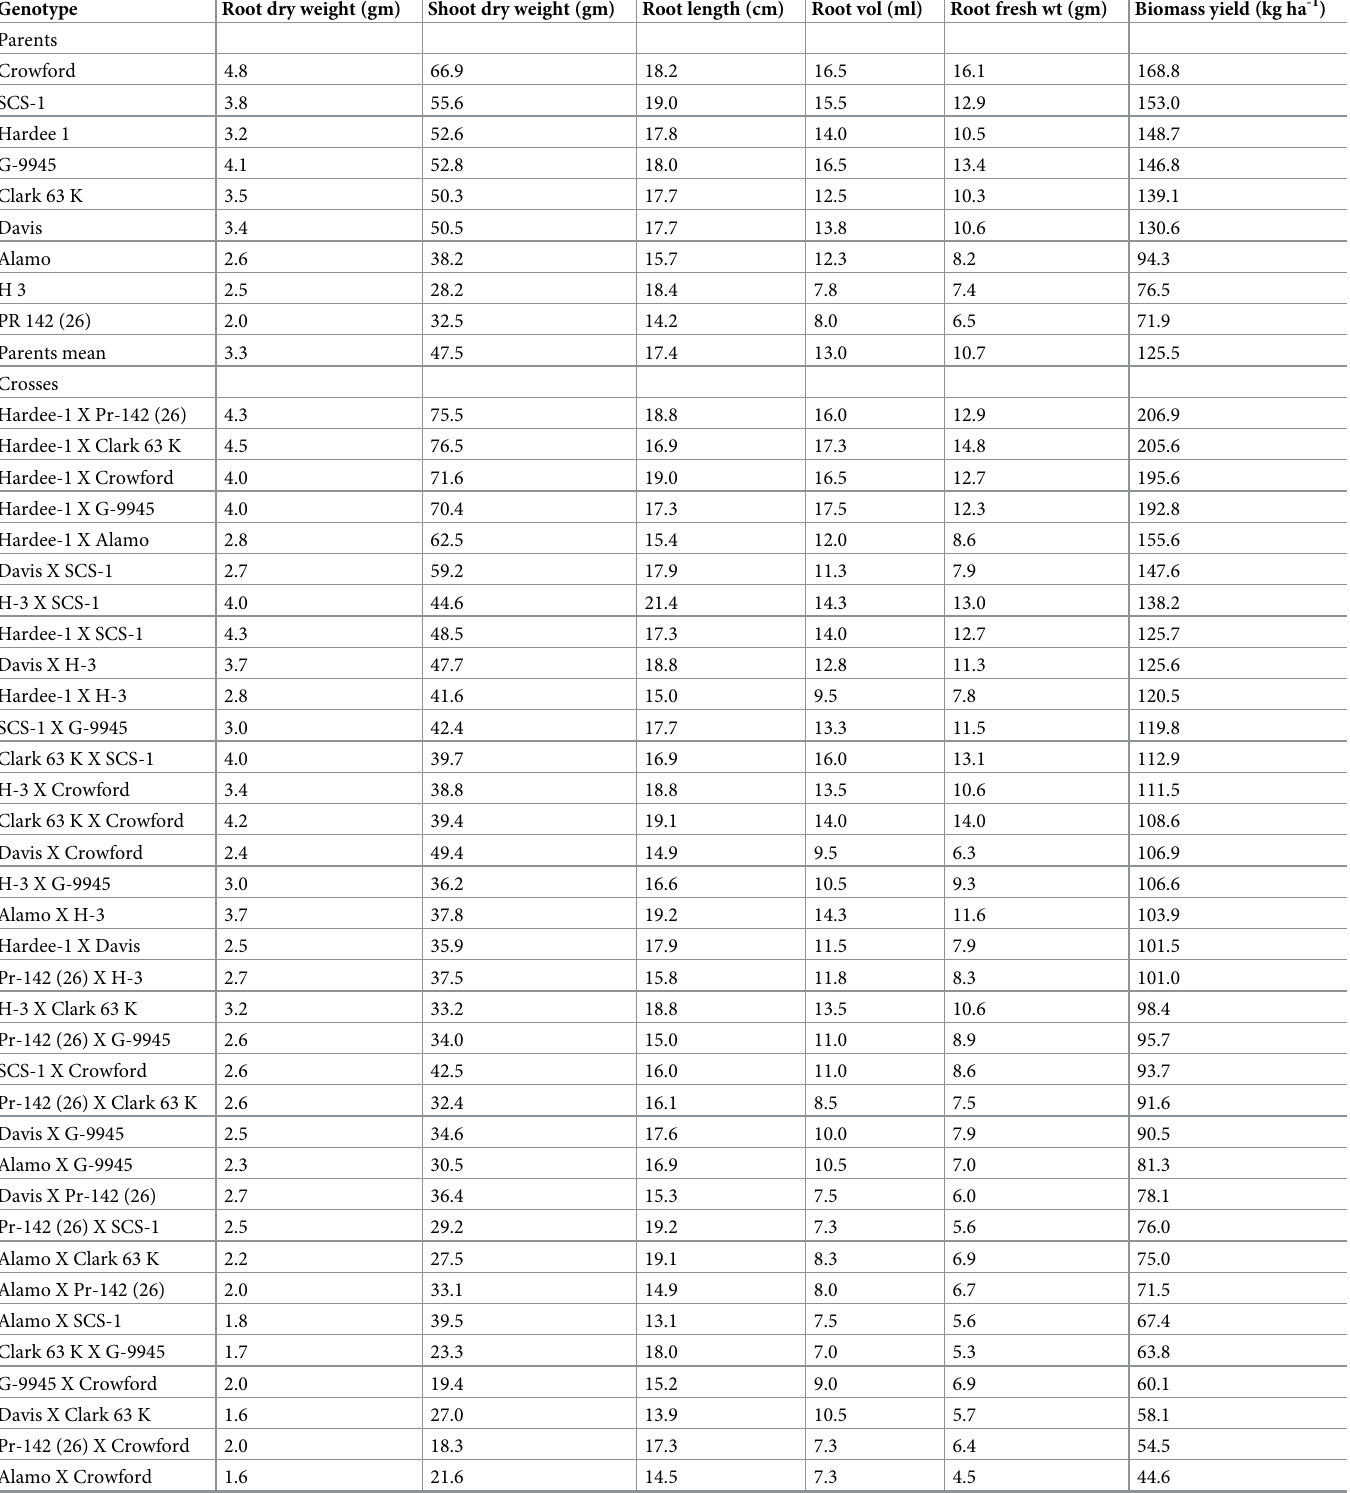
Table 3. Mean values of root agronomic traits of soybean parental genotypes and their crosses under low P conditions.